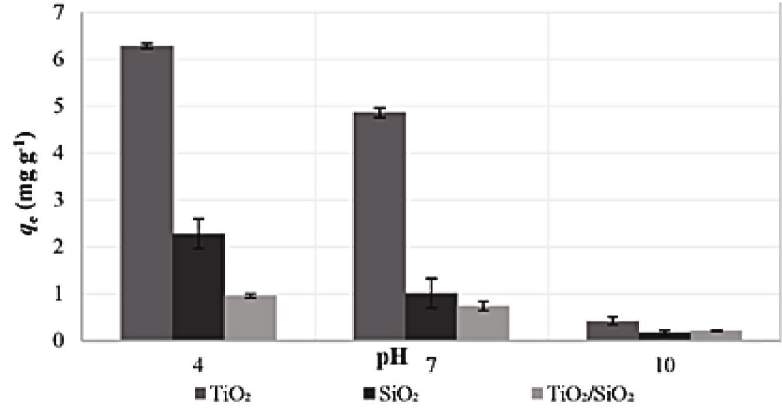
Fig. 3 – Equilibrium cefdinir uptake on the adsorbents as a function of pH (T = 25 °C, C = 10 mg L –1 0